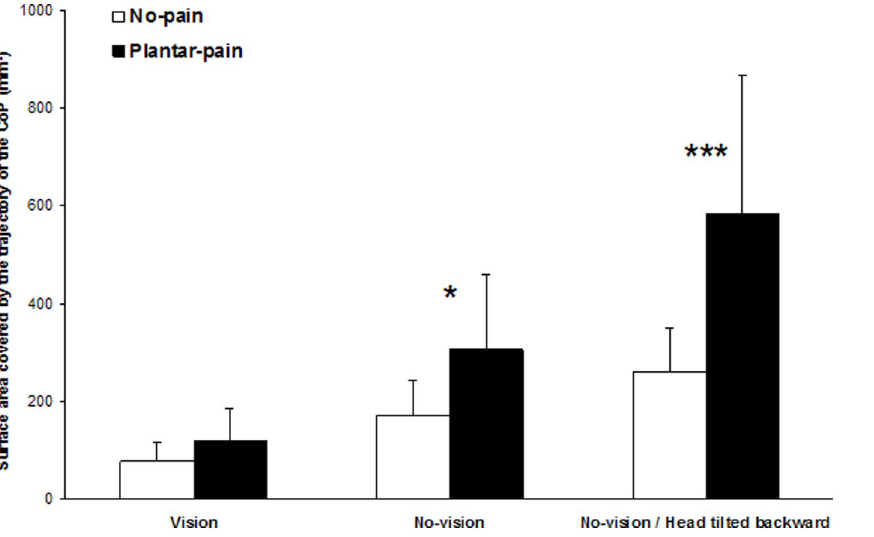
Figure 1. Mean and standard deviation of the surface area covered by the trajectory of the CoP obtained for the three sensory conditions and the two pain conditions. The No-pain condition is represented by white bars and the Plantar-pain condition by black bars . The significant P values for comparison between No-pain and Plantar-pain conditions are reported (*: P , 0.05; ***: P , 0.001).